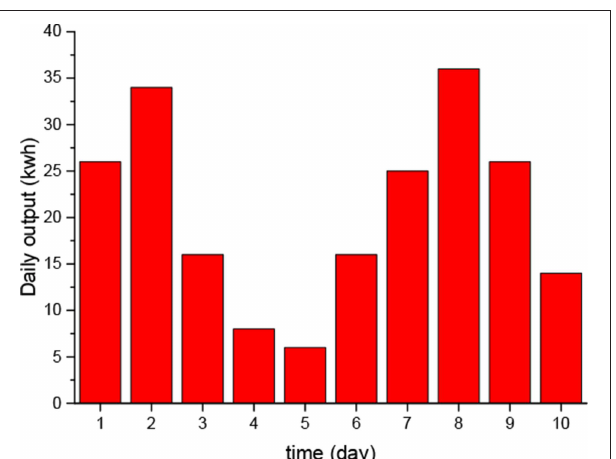
FIGURE 15 | Daily generated output bar